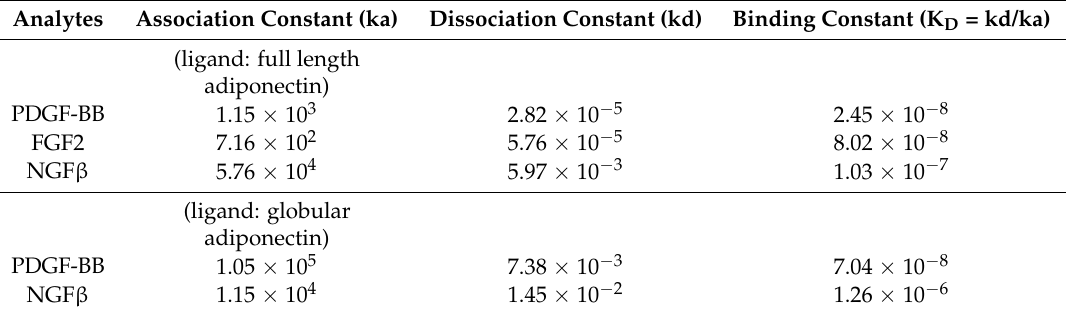
Table 2. Summary of analyte binding to adiponectin.